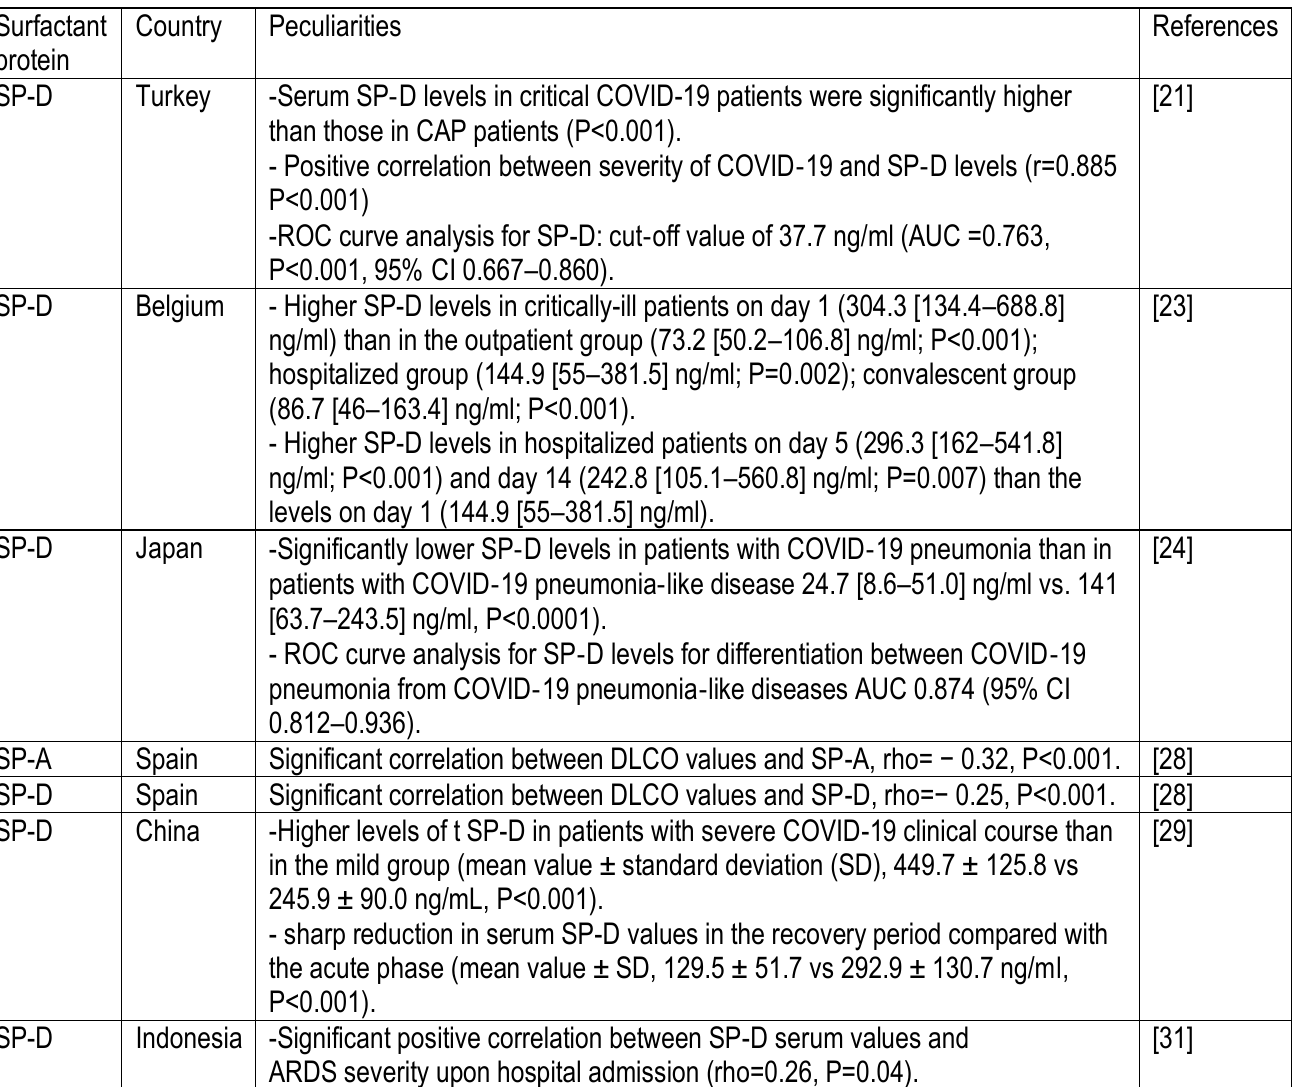
Table 1. Peculiarities of serum surfactant protein levels in COVID-19